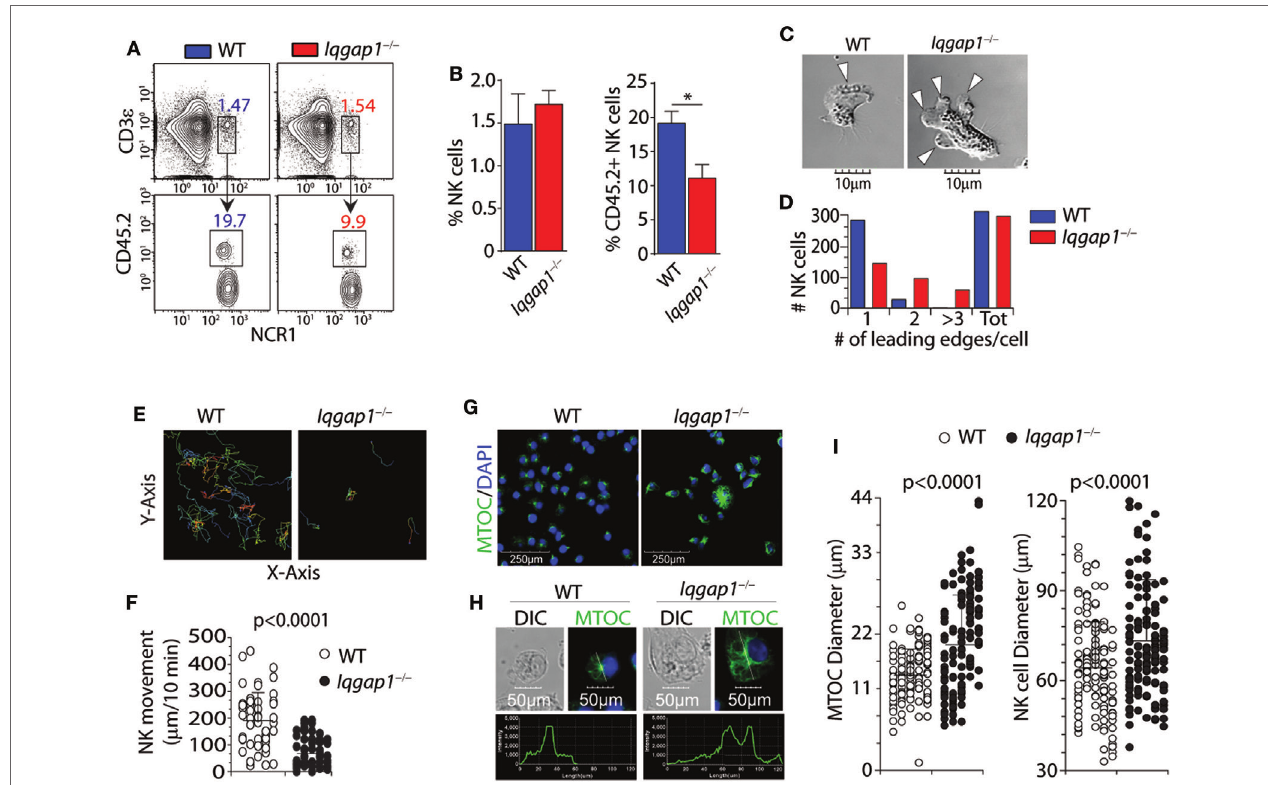
FigUre 2 | Bone marrow (BM) localization, cell polarization, and motility of Iqgap1 − / − natural killer (NK) cells. (a) Representative dot plots and (B) quantified percentages of CD45.2-labeled NK cells (CD3 ε − NCR1 + ) illustrating sinusoidal (CD45.2 + ) vs. parenchymal (CD45.2 − ) localization within the BM of wild-type (WT) and Iqgap1 − / − mice. (c) Representative images of IL-2-cultured WT and Iqgap1 − / − NK cells showing the formation of lamellipodia at the leading edge and (D) quantification of the total number of leading edges per cell in > 250 NK cells. (e) Traces of IL-2-cultured WT and Iqgap1 − / − NK cells with the quantified movement of these cells over time as shown in panel (F) . (g) Confocal microscopy of WT and Iqgap1 − / − NK cells labeled with anti-tubulin antibody and counterstained with DAPI. (h) The intensity of tubulin fluorescence on a single-cell basis as well as quantification of microtubule organizing center (MTOC) and total NK cell diameter in 100 NK cells which are shown in (i) . Error bars represent SD (B) or SEM (F,i) using three to four mice in at least two independent experiments, * p < 0.05 using two-tailed Student’s t